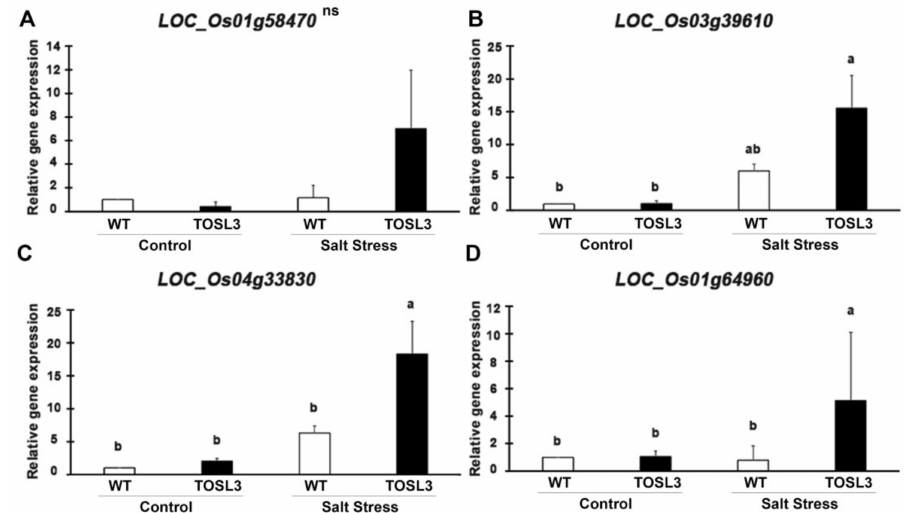
Figure 10. Gene expression analysis of LOC_Os01g58470 ( A ), LOC_Os03g39610 ( B ), LOC_Os04g33830 ( C ), and LOC_Os01g64960 ( D ) in WT and TOSL3 plants under control and salt stress conditions. Bar represents standard deviation of three biological replicates. The measurement was performed with three technical replicates. The data were presented as the mean ± SE and a different letter above the bar showed the significant difference in means ( p < 0.05) based on Tukey’s range test analysis. ns represents no statistically significant difference among